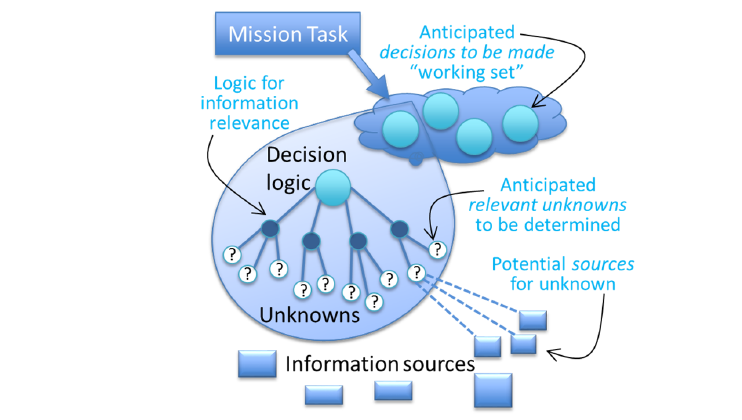
Figure 1. A conceptual architecture for anticipatory information